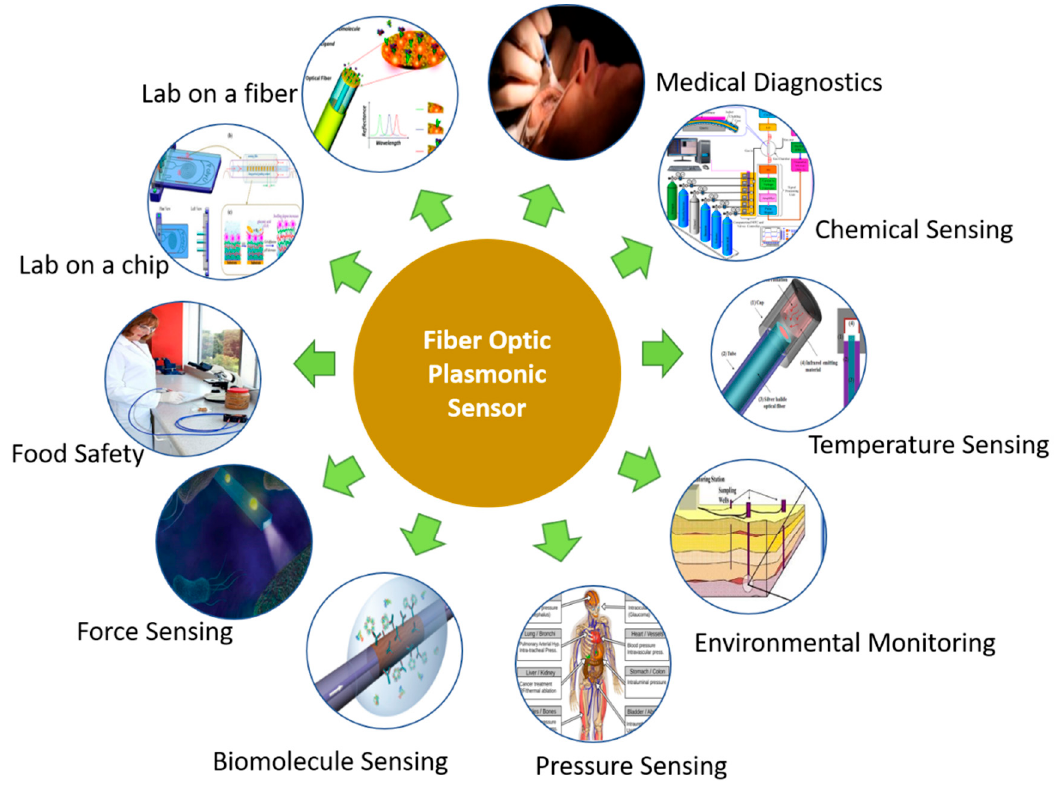
Figure 1. Biological applications of fiber optic plasmonic sensor [11–14,16,17].